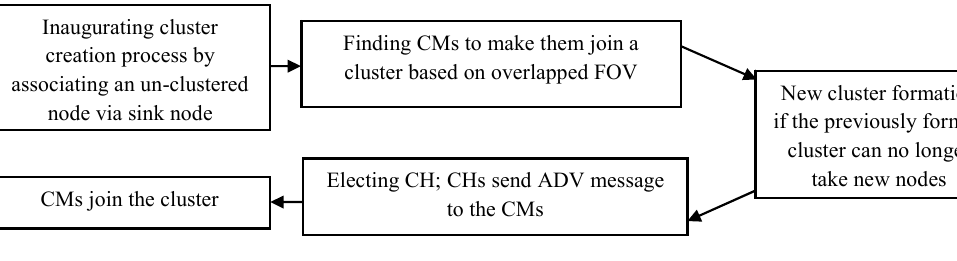
Figure 7. CH advertising to the CMs.